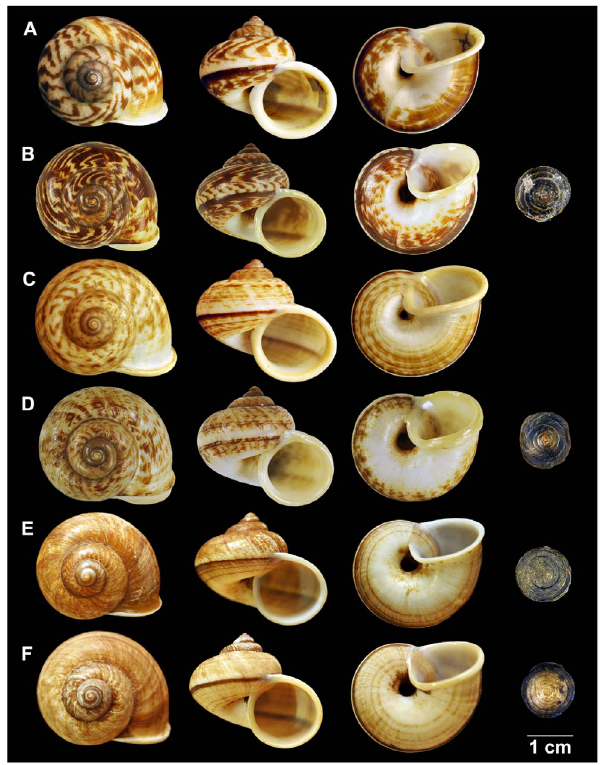
Figure 4. Shell of Cyclophorus species. (A, B) Cyclophorus fulguratus s.s. (A) Lectotype NHMUK 20130117/1, and (B) specimen CUMZ 1327 from Khao Chakan, Sra Kaeo (Clade A; Fig. 1B). (C, D) Cyclophorus rangunensis (C) Lectotype NHMUK 20130091/1, and (D)